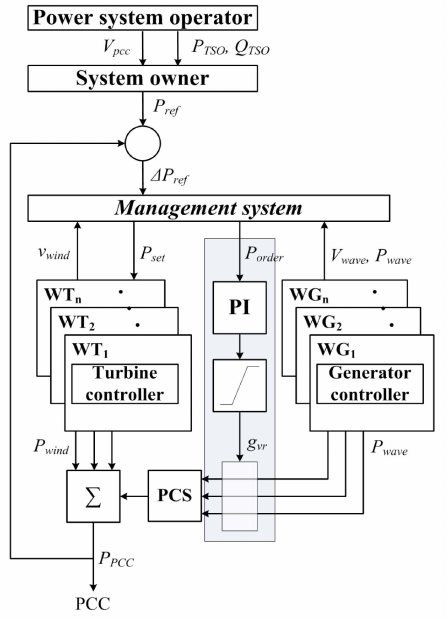
Figure 8. Real power control process of